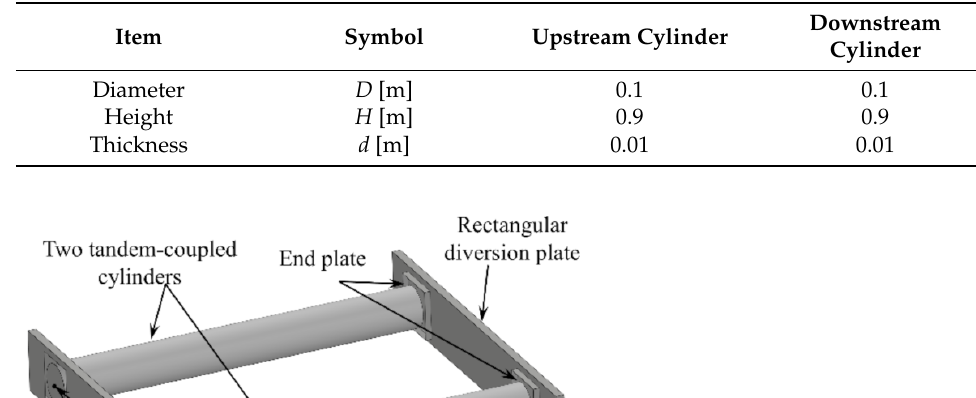
Table 3. The parameters of the circular cylinder.